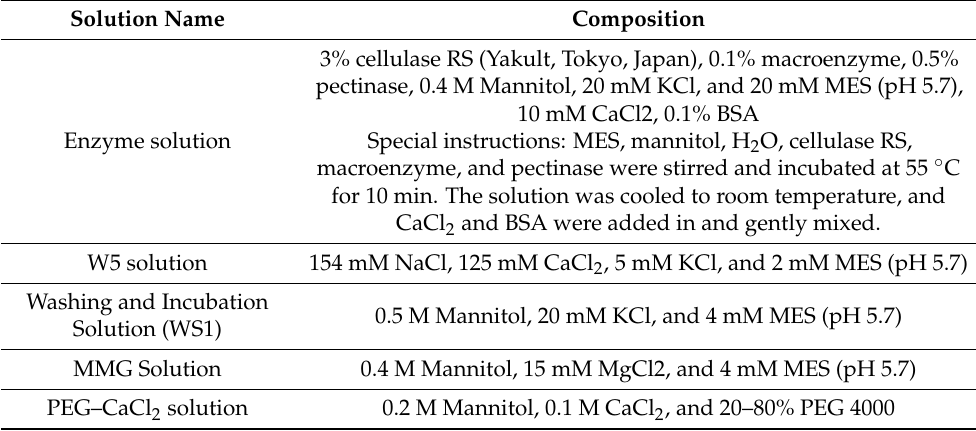
Table 2. Solutions used for peanut protoplast isolation and